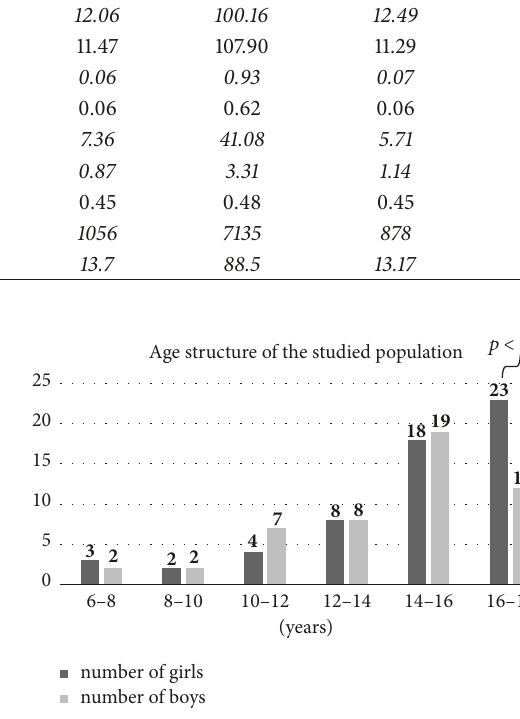
Figure 1: Sex distribution in particular age